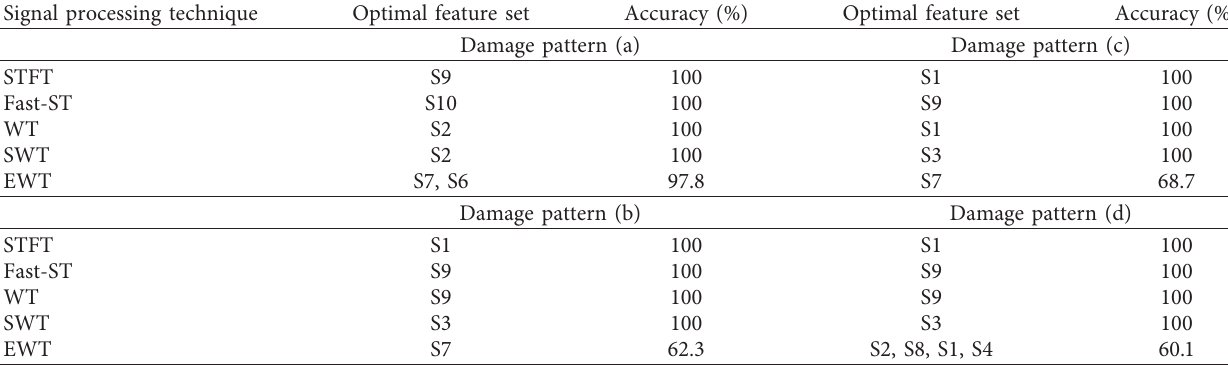
Figure 5: Four damage patterns. (a) No stiffness in 1 st floor brace, (b) no stiffness in one 1 st floor brace, (c) no stiffness in one 1 st floor brace, no stiffness in one 3 st floor brace, and beam-column connection weakened, and (d) 2/3 stiffness in one 1 st floor brace. Table 5: Classification accuracy of the selected feature subset obtained by using different feature extraction methods for the IASC-ASCE SHM benchmark structure (for sensor